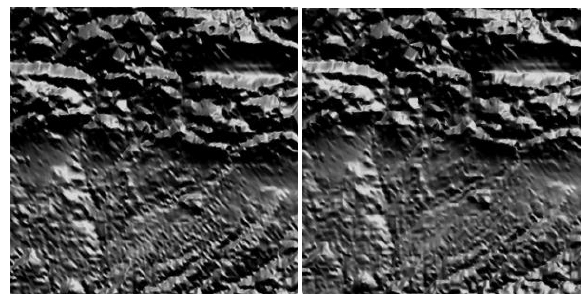
Figure 7. Relative DEM (left) and RPC DEM